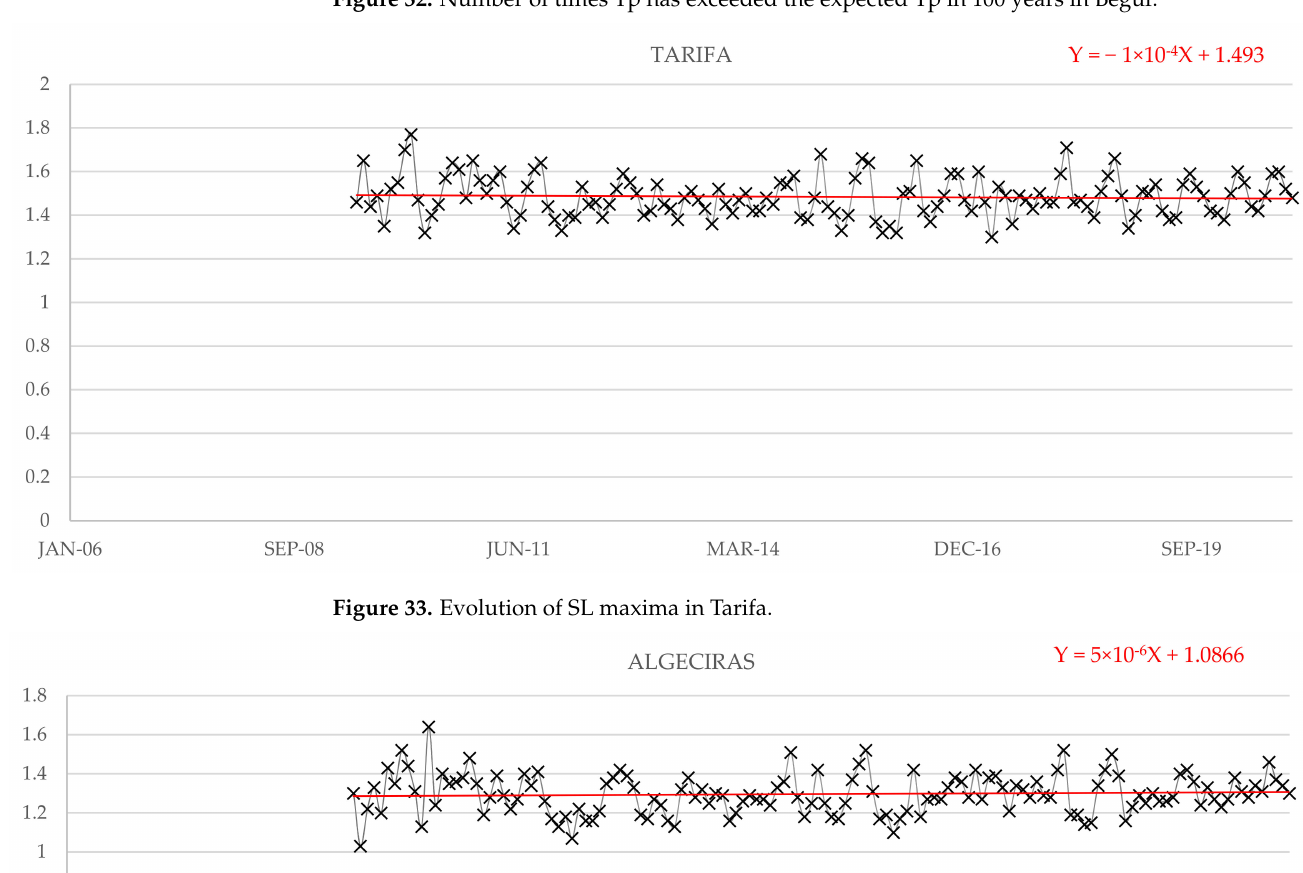
Figure 32. Number of times Tp has exceeded the expected Tp in 100 years in Begur.